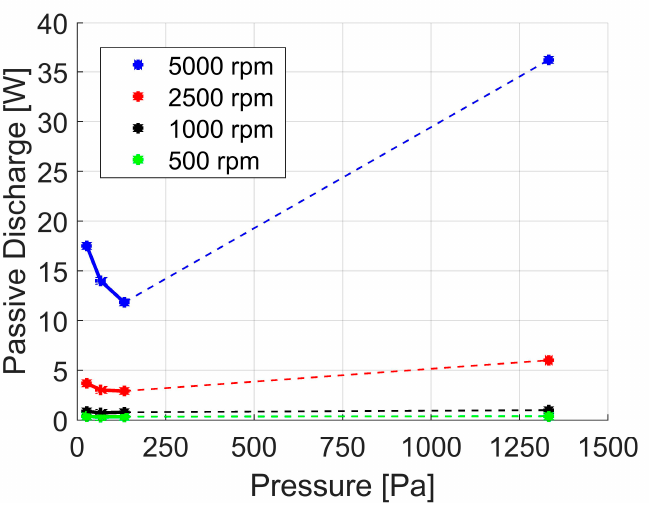
Figure 4. Total rotor passive discharge versus pressure at four distinct rotor speeds. Dashed lines are included to indicate trends in the measured data.